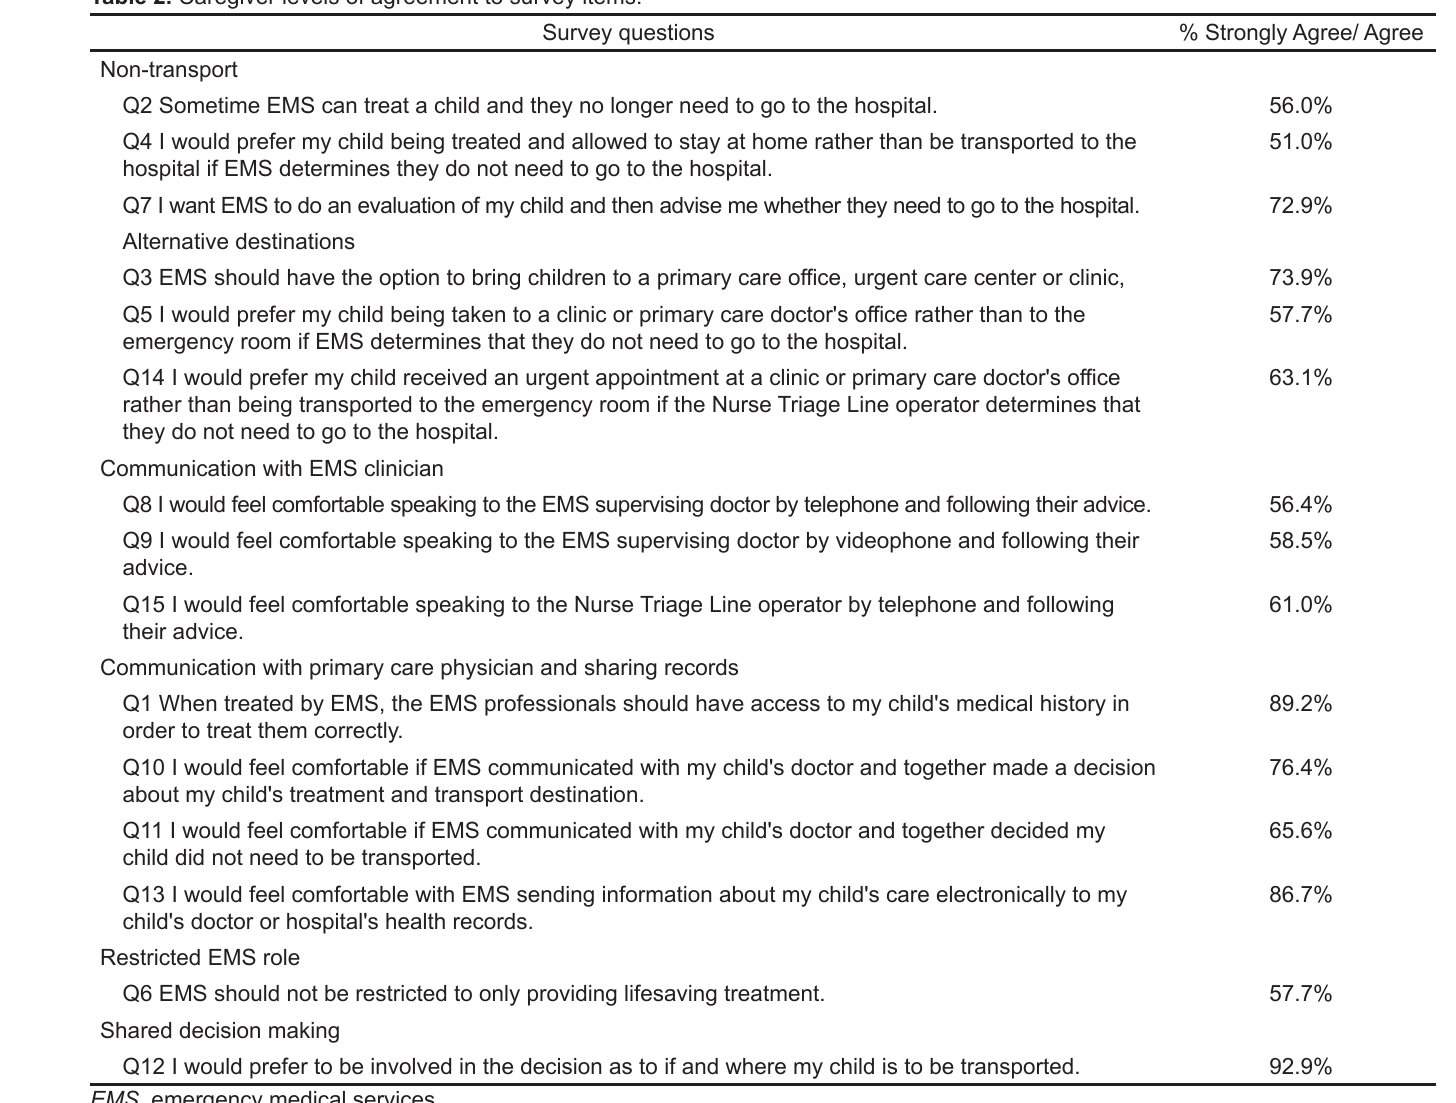
Table 2. Caregiver levels of agreement to survey